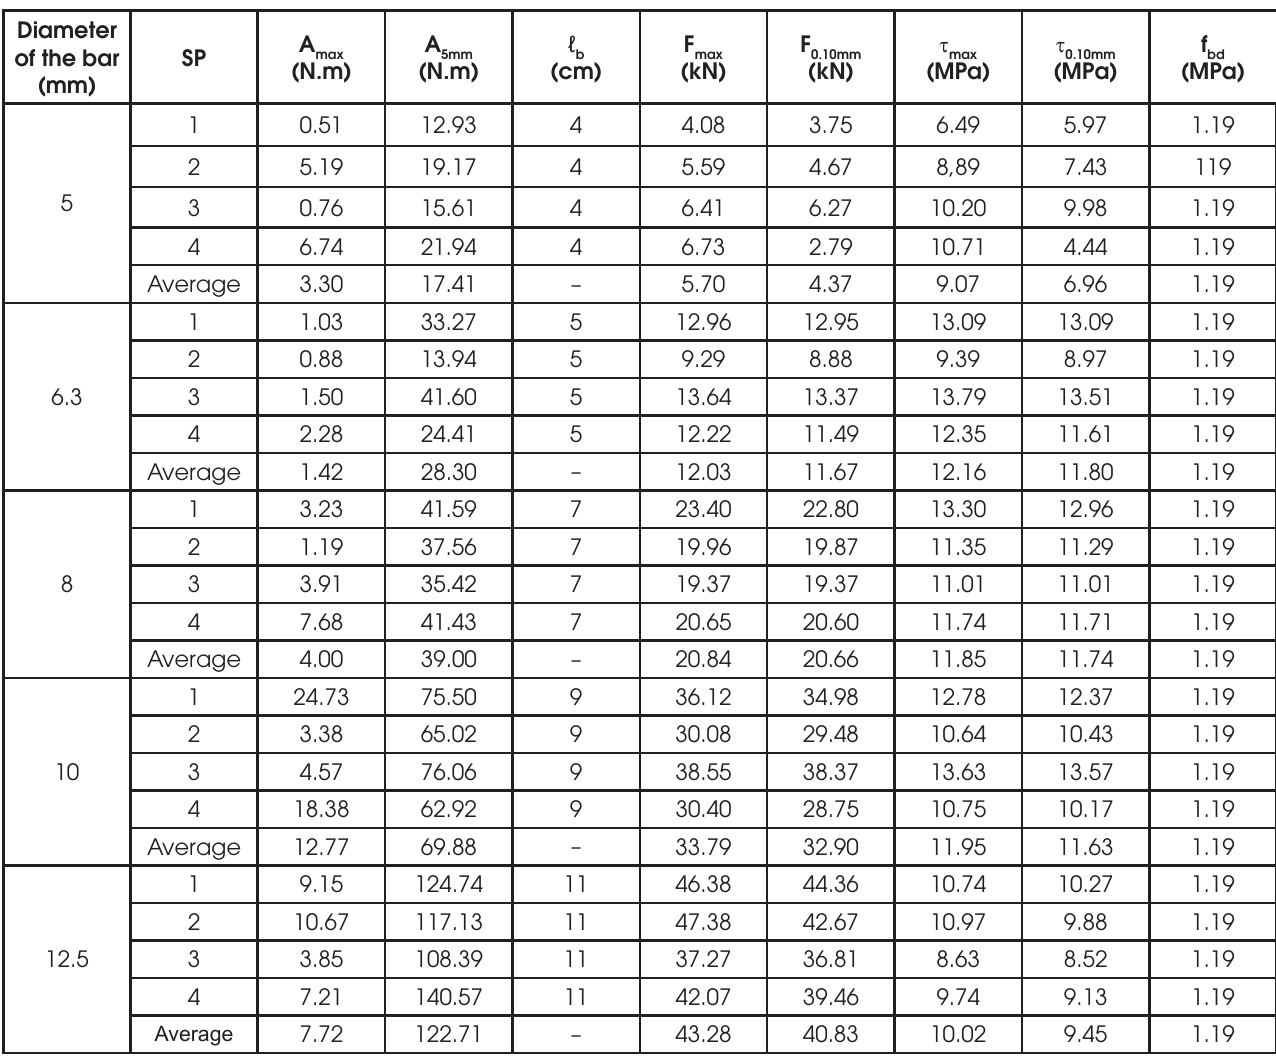
Results of the pull-out tests with models of 1 st Batch of SLCEB